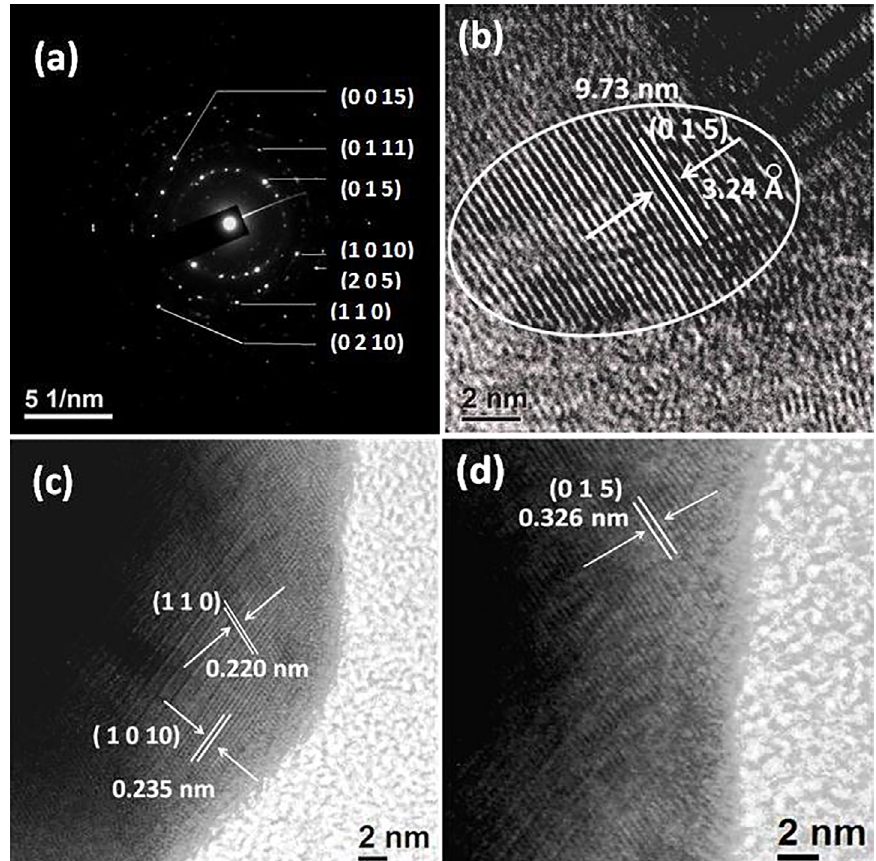
Te powders (b). Brightfield 2 3 Te nanoparticle (marked by white ring) (c) & (d) HRTEM 2 3 Te in 10h ball-milled powder 2 3